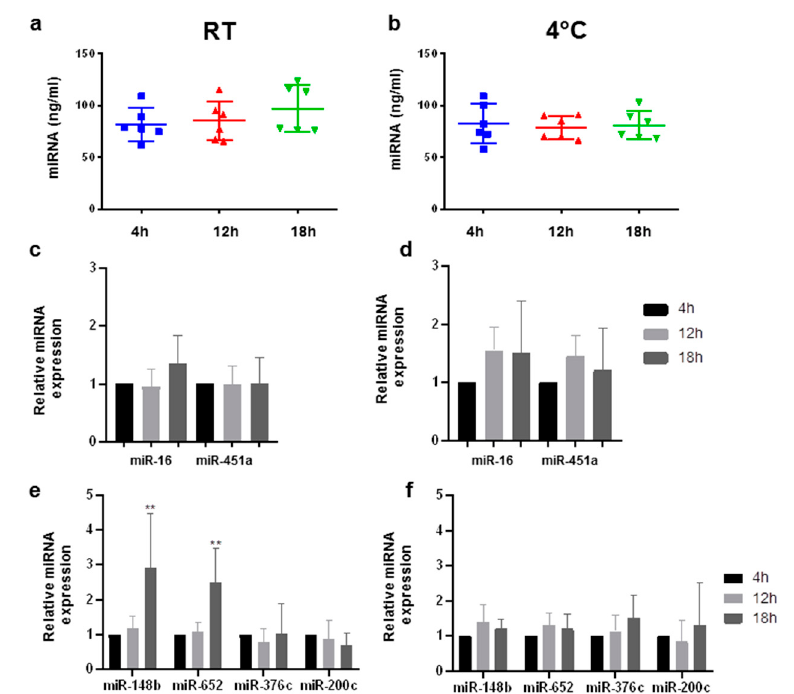
Figure 1. Stability of cell-free microRNAs (cf-miRNAs) stored in EDTA monovettes. Content of cf-miRNA (ng/mL) in plasma after storing blood for 4, 12, and 18 h at room temperature (RT) ( a ) and 4 °C ( b ) in six healthy subjects. Bar plots showing enrichment of miR-16 and miR-451a after 12 and 18 h, relative to 4 h, stored at RT ( c ) and 4 °C ( d ). qRT-PCR results showing the differences in miR-148b, miR-652, miR-376c, and miR-200c after 12 and 18 h stored at RT ( e ) and 4 °C ( f ), relative to 4 h. Stars represent level of significance with (**) for p -value < 0.01.